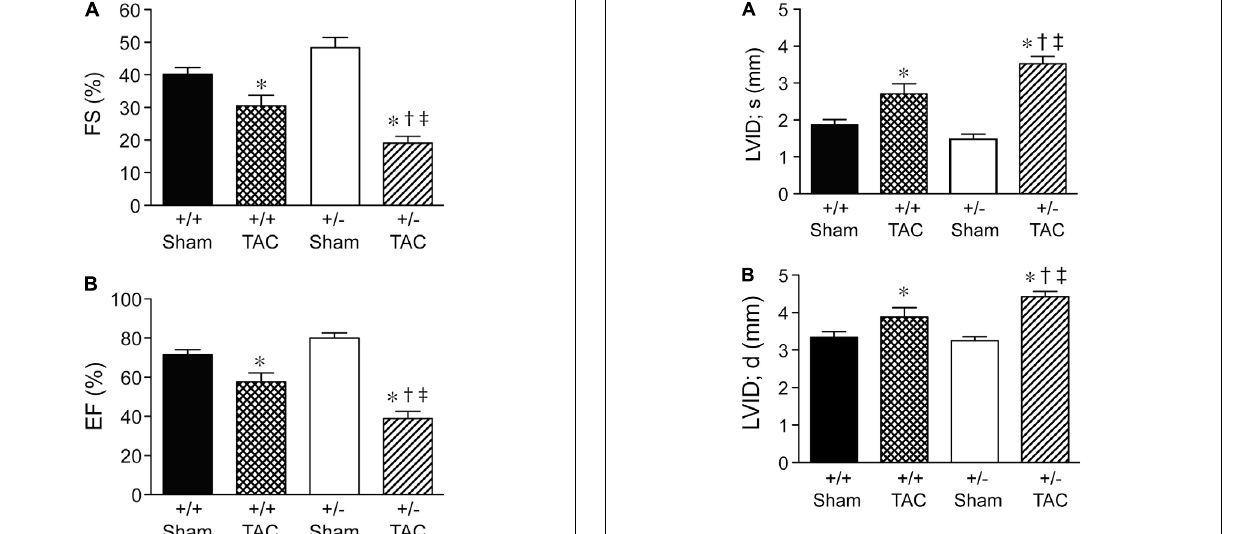
FIGURE 4 | Left ventricular dilation at 4 weeks post-TAC in Speg + / − mice. Transverse aortic constriction (TAC) or sham surgery (sham) was performed on 8-week old Speg wild type (+/+) and heterozygous (+/–) mice. Echocardiography was performed on the mice (sham, n = 7/group; TAC, n = 7–11/group) after TAC or sham surgery. Left ventricular internal diameter (LVID, mm) was assessed in (A) systole (s) and (B) diastole (d). Analysis by one-way ANOVA ( P < 0.05), with significant comparisons ∗ versus sham of the same group; † versus Speg + / + TAC; ‡ versus Speg + / + sham.